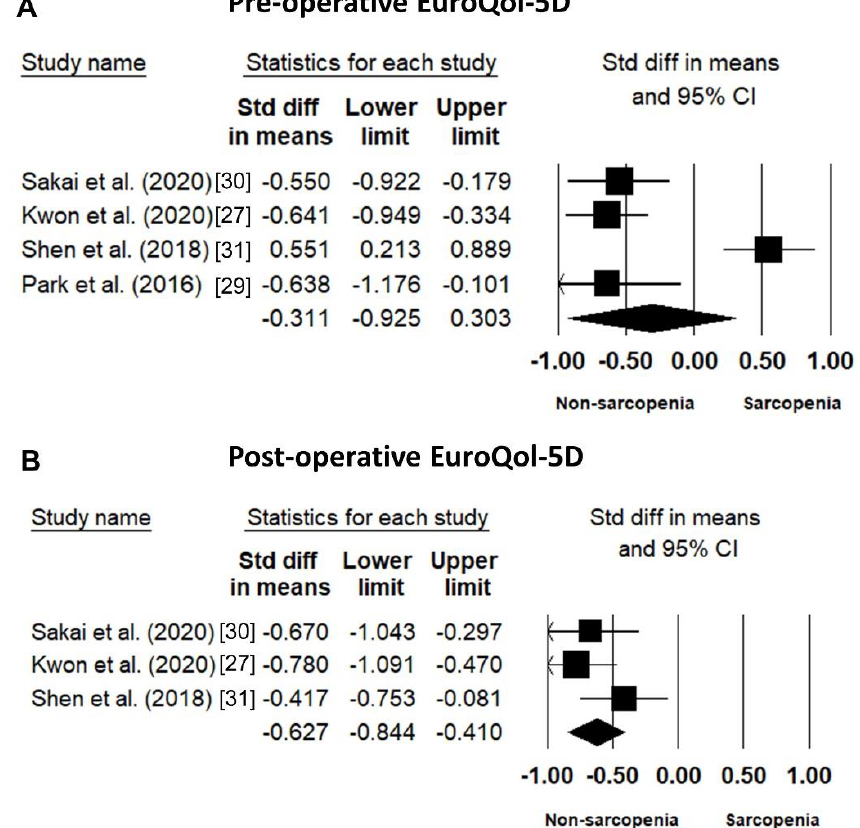
Figure 6. Forest plot of the standardized mean differences of the pre-operative ( A ) and post-operative ( B ) EuroQol-5D (EQ-5D) between patients with and those without sarcopenia.